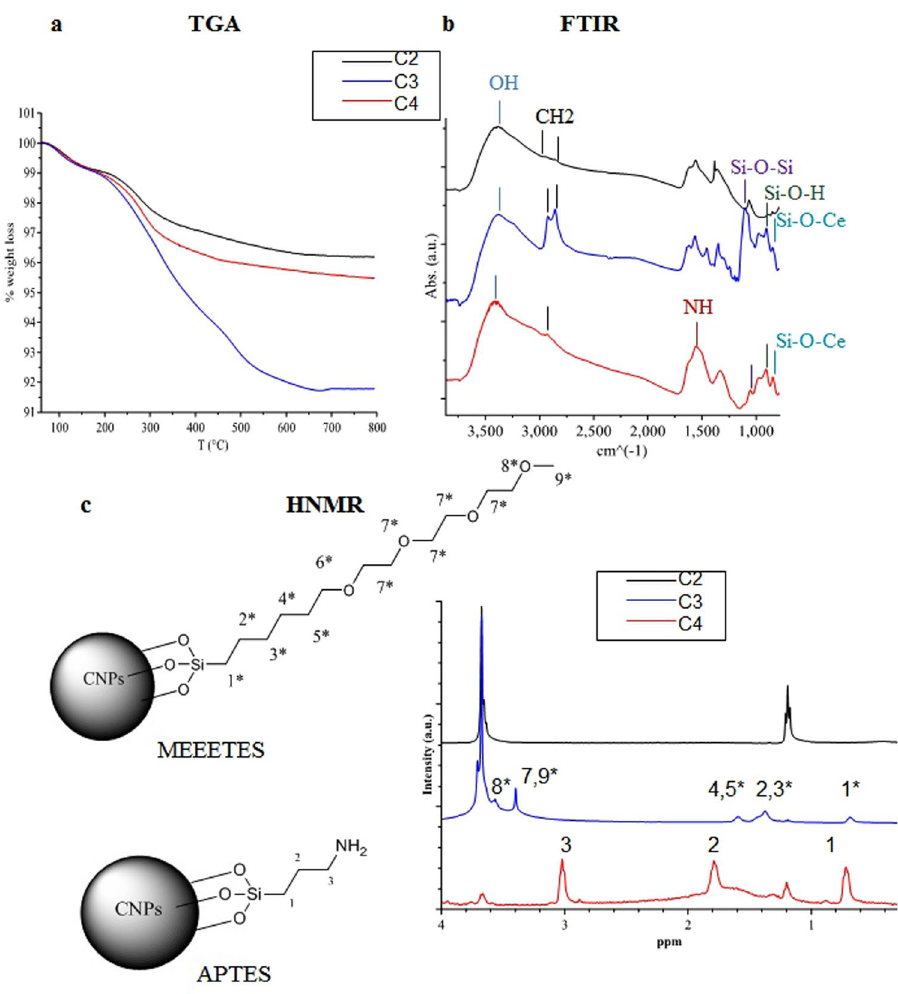
Figure 3. C2 nanoparticle surface silanization. ( a ) TGA analysis of C2, C3 and C4 samples. ( b ) FTIR absorbance spectra. ( c ) 1 H-NMR spectra of C3 and C4 samples. The peaks were assigned to the APTES and MEEETES molecular structures.